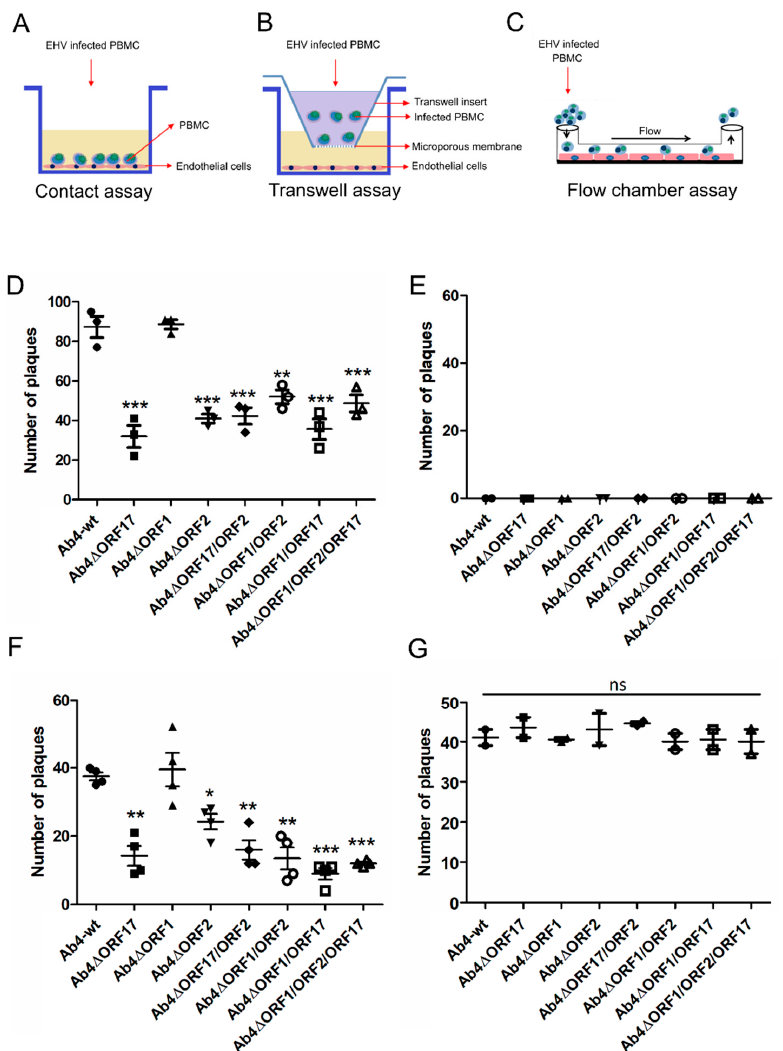
Figure 3. Virus transfer from EHV-1-infected PBMC to EC under static and dynamic flow conditions. Schematic diagram of ( A ) the contact assay, ( B ) the transwell assay, and ( C ) the flow chamber assay. PBMC were infected with Ab4-wt or mutant viruses at an MOI of 0.1 for 24 h. ( D ) The contact assay was performed after sorting of infected cells. Virus plaques were counted after 24 h. ( E ) As a control, infected PBMC were placed into a transwell insert without direct contact between PBMC and EC. The flow chamber assay was performed for the mutant ( F ) and corresponding revertant ( G ) viruses. Data are presented as mean plaque numbers ± SD; ( n = 3; One-way ANOVA test followed by multiple